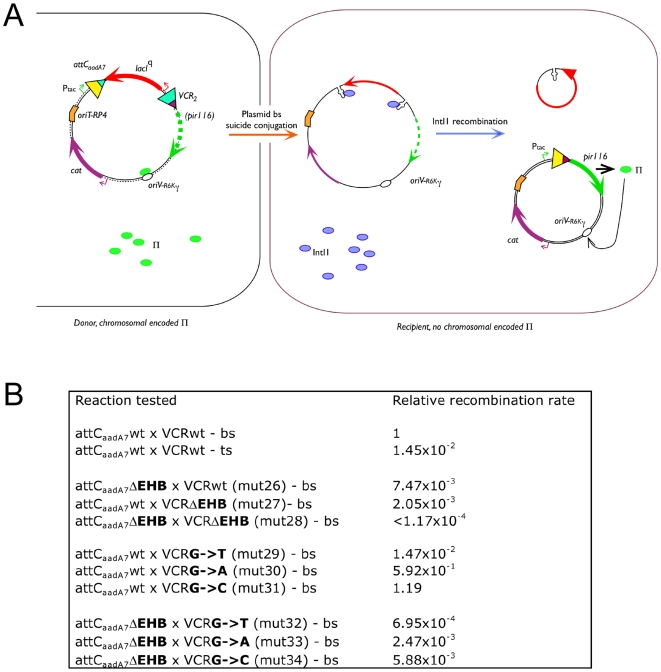
Schematic representation of the in vivo deletion assay and recombination frequencies of the different mutants.(A) Schematic representation of the in vivo deletion assay. The in vivo deletion assay is based on the conjugation assay previously developed for the in vivo integration assay. In its original form, the pSW carrying the synthetic cassette [Ptac]-attCaadA7-lacIq-VCR2/1-pir116* is dependent on the Π protein (green ovals) produced in trans in the donor strain (left), as the pir116* gene is not expressed. As the recipient strain lacks the pir gene, the pSW plasmid replication can only be achieved after the deletion of the lacIq gene by an attCaadA7×VCR2/1 recombination reaction mediated by IntI1 (blue ovals), which allows the expression of pir116* gene from the Ptac promoter. The recombination events are selected on the Cm resistant marker of the pSW plasmid. The assay is presented in more detail in the Materials and Methods. The pir116, lacIq, and cat gene are, respectively, schematized by green, red, and purple arrows, and their promoters are indicated by the same colours. The origin of replication (oriV
R6Kγ) and the origin of transfer (oriT
RP4) of the pSW-attC plasmid are shown by a white oval and an orange bent rectangle, respectively. (B) Recombination frequencies obtained after bottom (bs) or top (ts) strand injection. The recombination frequencies are normalized with attCaadA7WT×VCRWT-bs frequency and represent a mean of three independent experiments. The location of the recombination events were determined (see Materials and Methods).